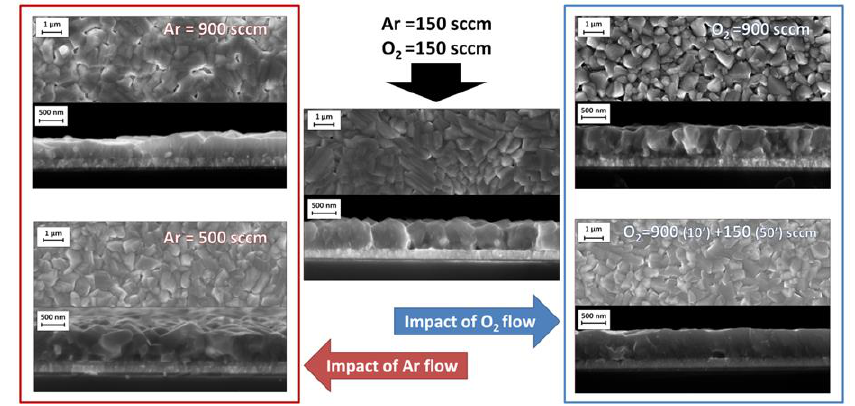
Figure 2. Comparison of BiFeO 3 (BFO) thin films deposited under different conditions. BFO reference sample is in the center, on the left the impact of the argon flow and on the right the impact of the oxygen flow on BFO are presented. For every condition, FE-SEM top view and cross sections are